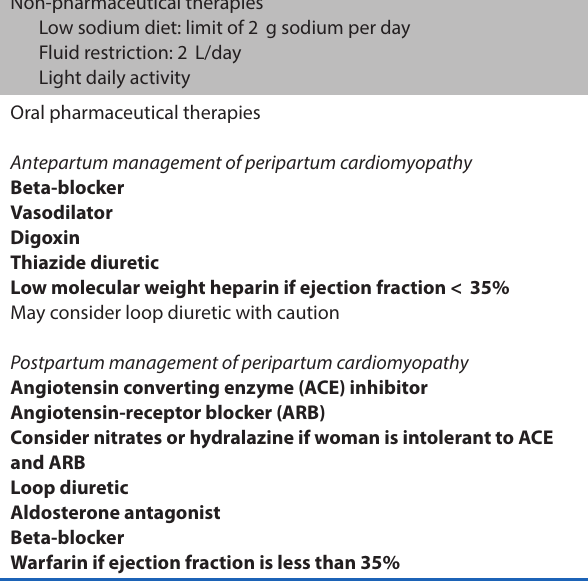
Table 1: Management of compensated heart failure in peripartum cardiomyopathy 9,20 Non-pharmaceutical therapies Low sodium diet: limit of 2 g sodium per day Fluid restriction: 2 L/day Light daily